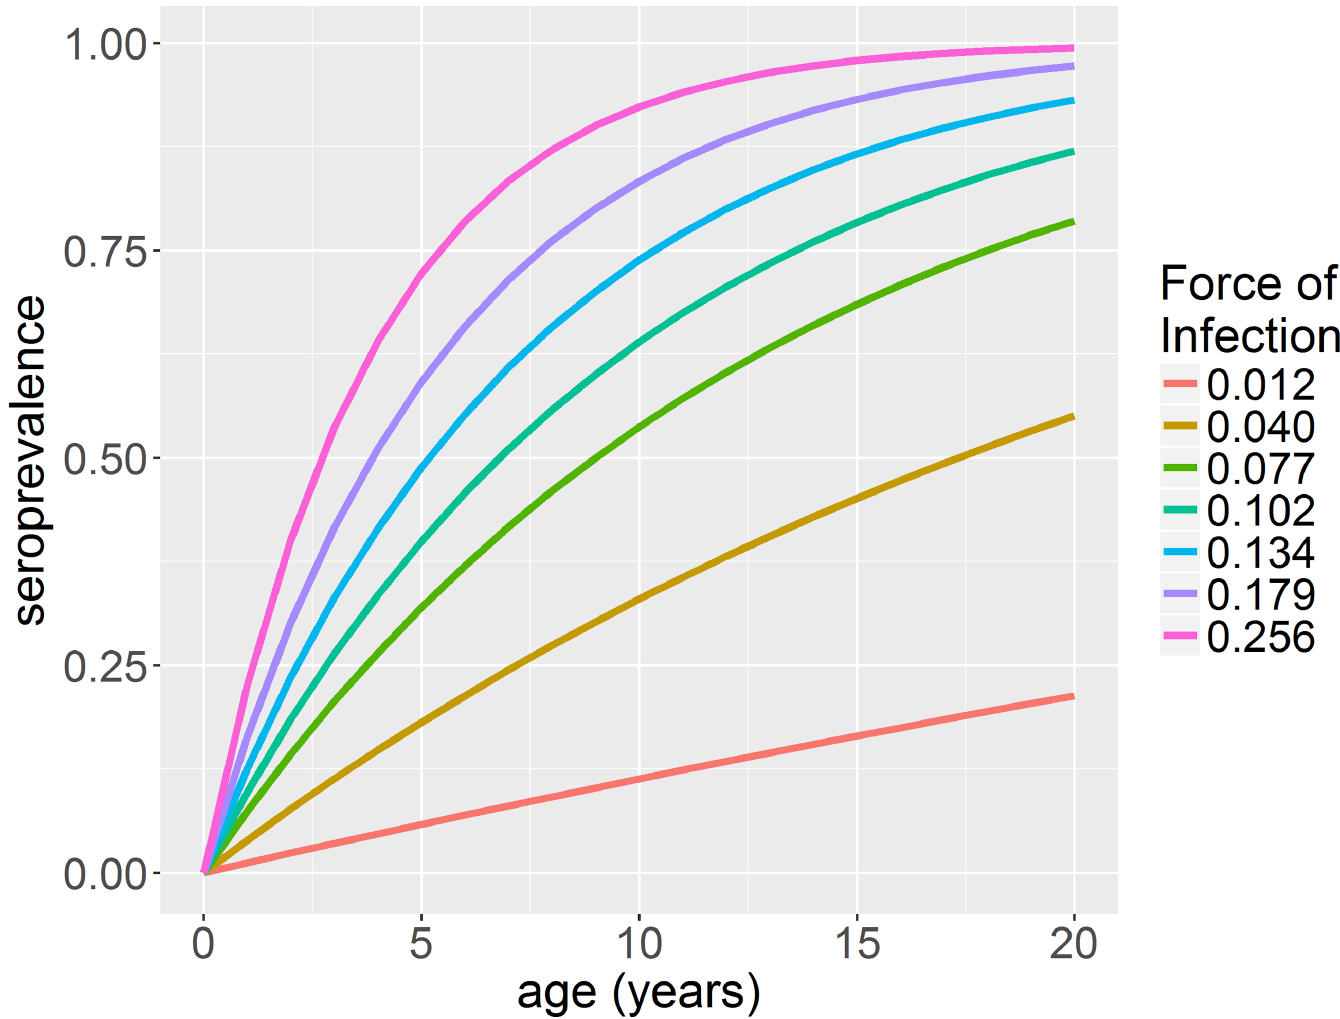
Fig 1. Change in seroprevalence with age at different transmission intensities. Transmission intensity values are given at the end of each seroprevalence curve.